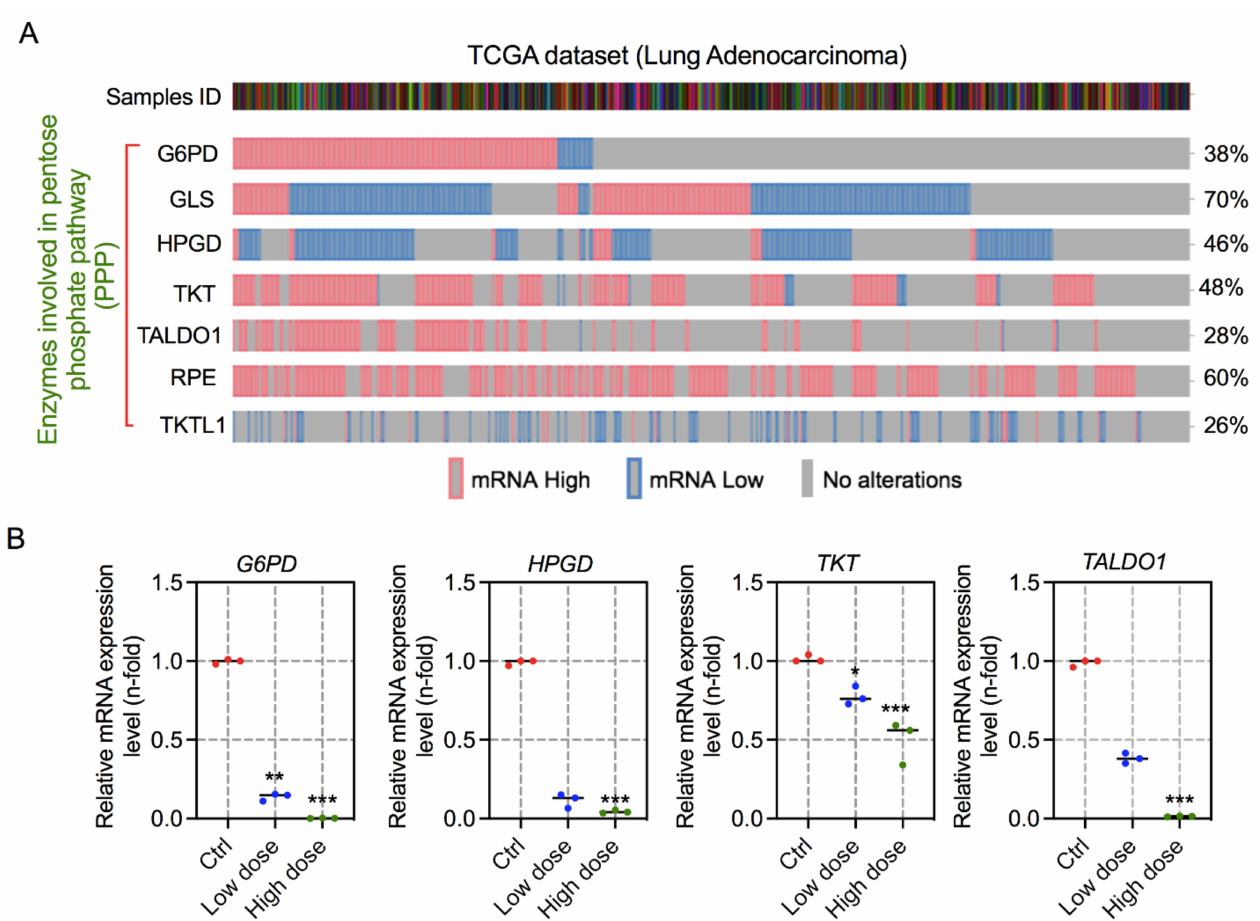
Figure 5. Treatment with 6-aminonicotinamide (6-AN) reduces the expression of the main enzymes involved in the pentose phosphate pathway (PPP) . ( A ) TCGA analysis of the main enzymes involved in PPP for mRNA expression. ( B ) qRT-PCR analysis of mRNA expression of PPP-related genes such as G6PD, HPGD, TKT, and TALDO1 following 6-AN treatment in H460 cancer cells under both conditions. * p < 0.05; ** p < 0.01; *** p <